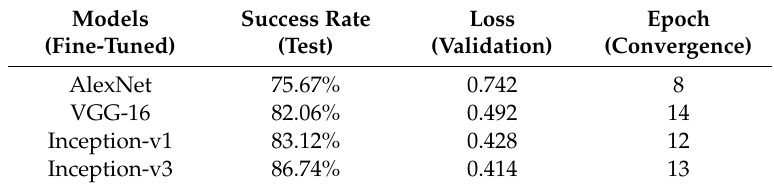
Table 4. Performance of various pre-trained CNNs fine-tuned on the dataset without data augmentation.